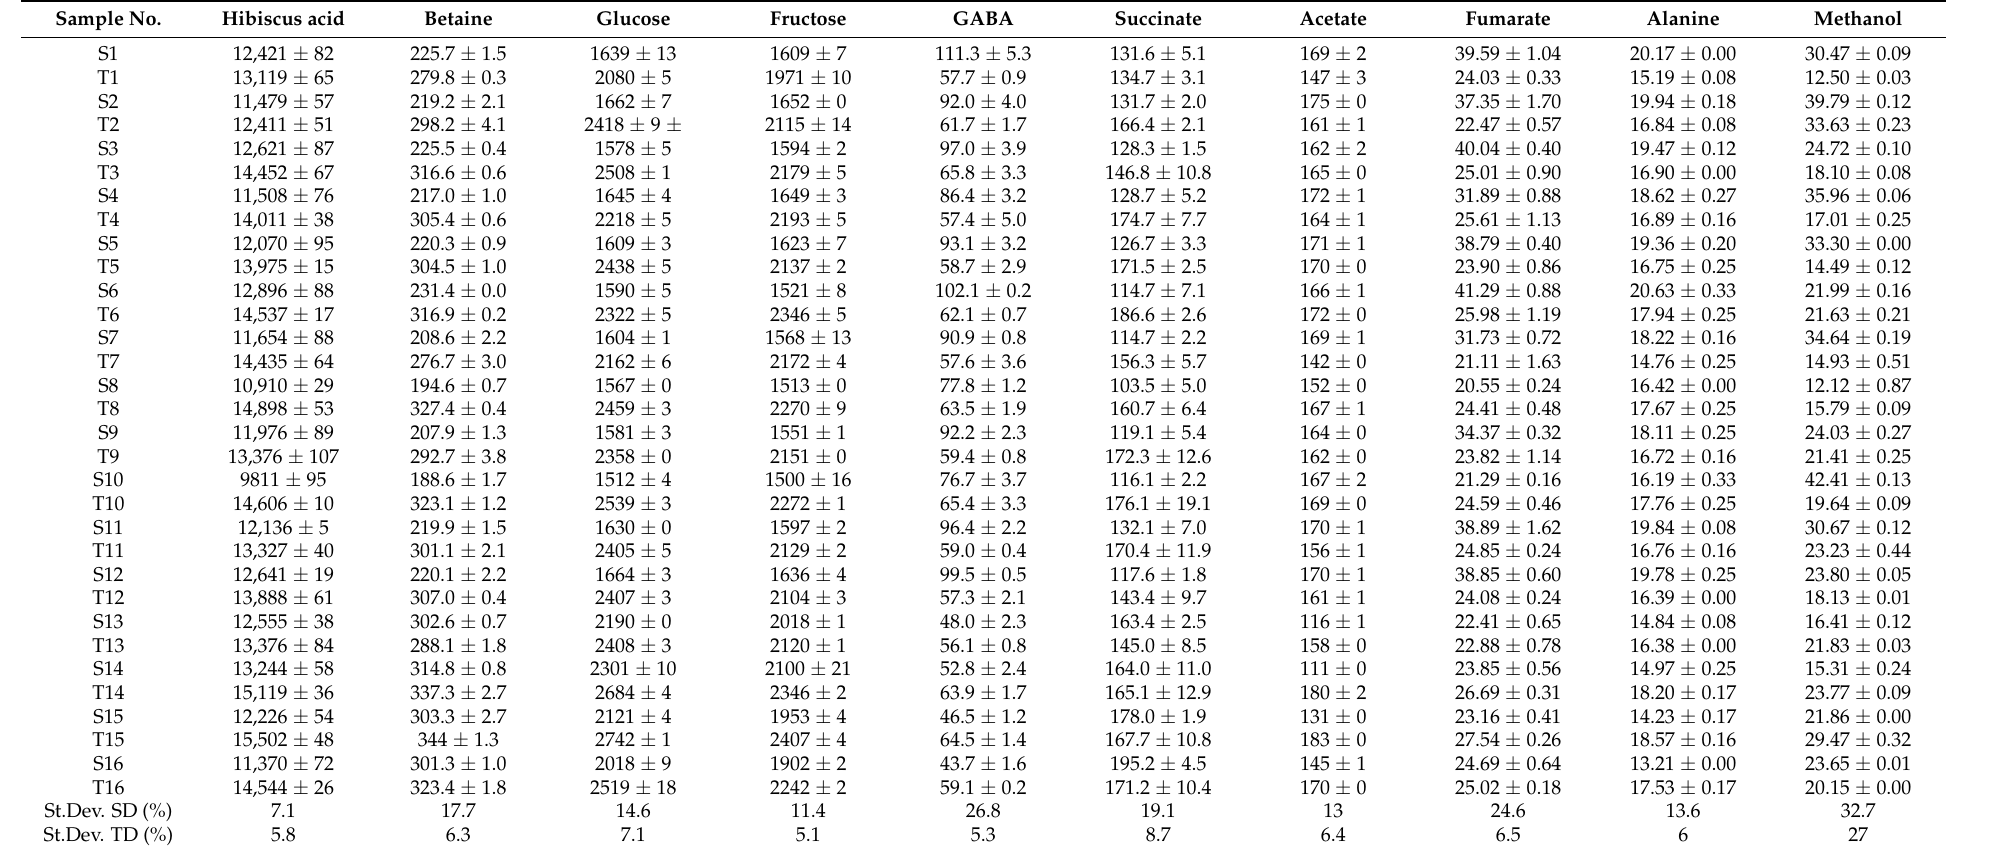
Table 4. Concentration of the main polar metabolites of H. sabdariffa calyx (mg in 100 g of dry powder) in shade (S)and tray (T) dried samples. Sample